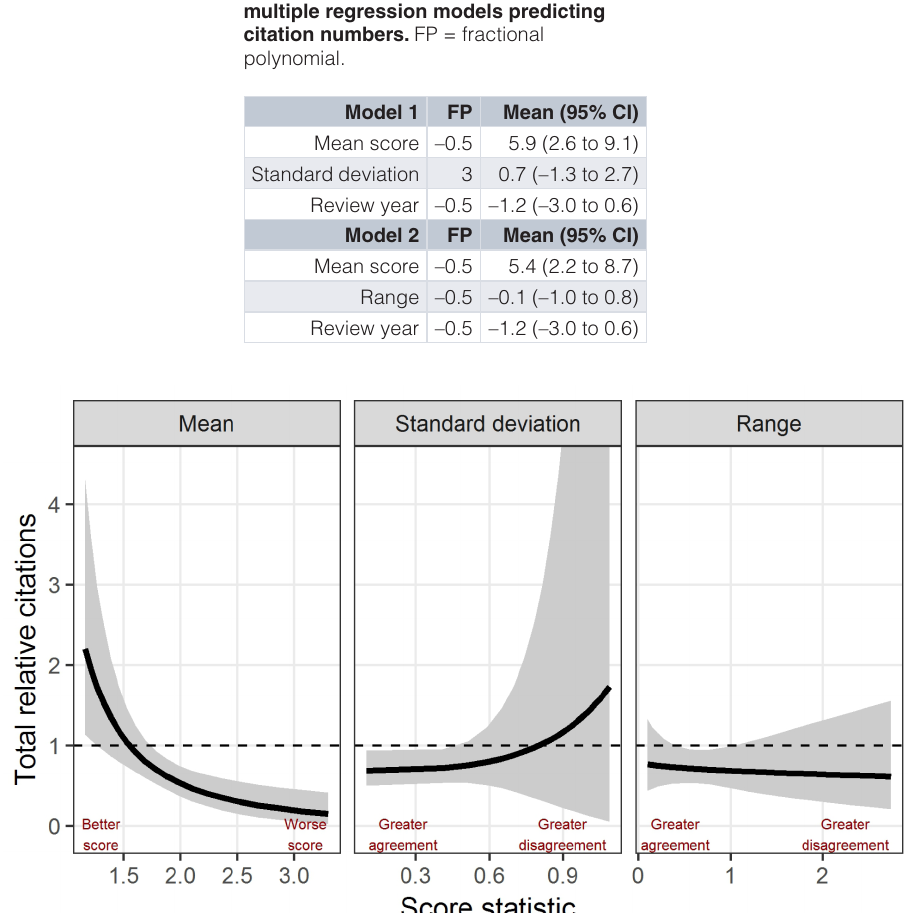
Figure 5. Predicted relative citations using the best fractional polynomial for the application score statistics. The solid lines are the means and the grey areas are 95% confidence intervals. The dotted horizontal line at 1 represents the average citations, so values above this are better than